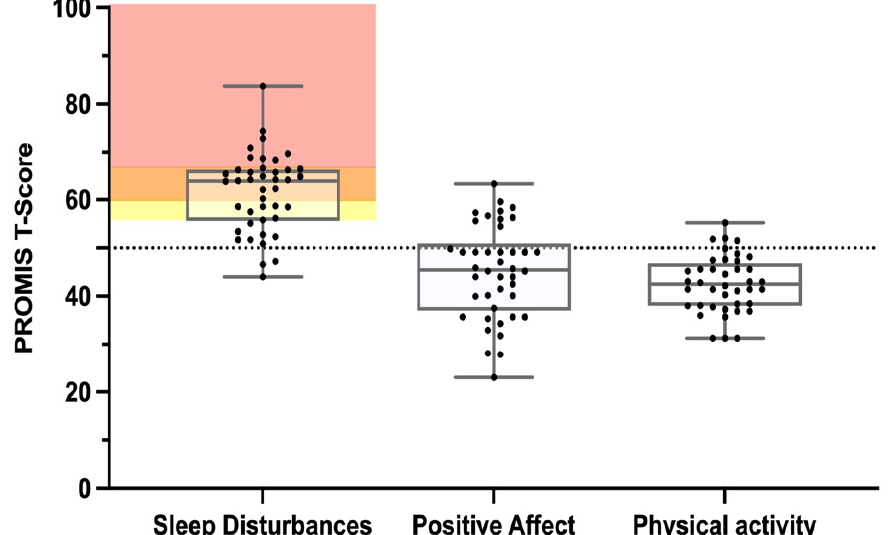
Figure 4. PROMIS parent proxy scores for sleep disturbance, positive affect, and physical activity before training with the Trexo. A t -score of 50 represents the mean of the general population. Severity of sleep disturbance thresholds are indicated by shading: red = severe ( ≥ 66), orange = moderate, and yellow = mild (<60 but ≥ 56).